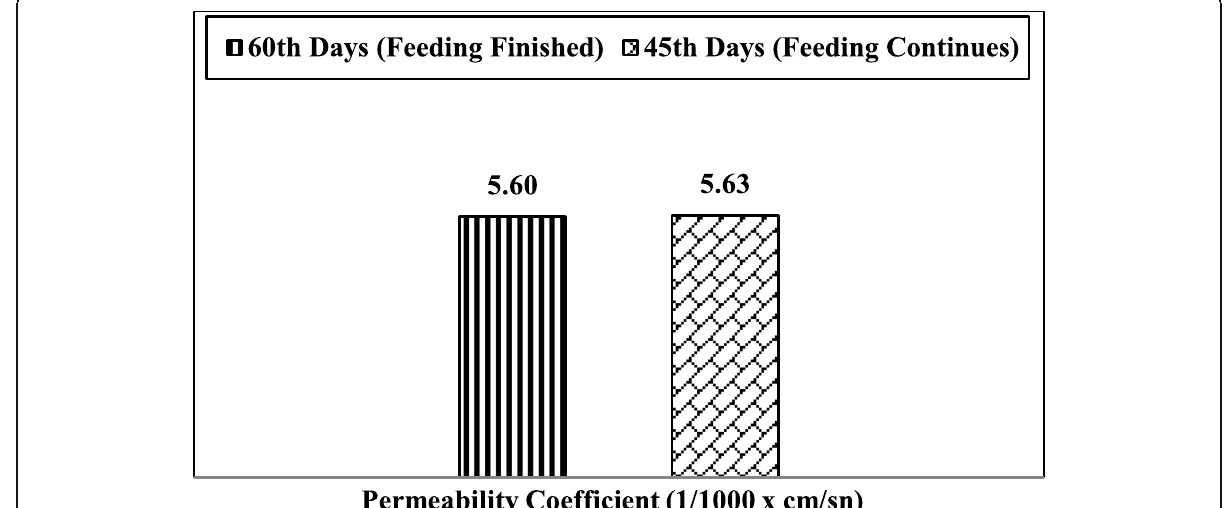
Fig. 6 Permeability coefficient during and after the completion of nutrient